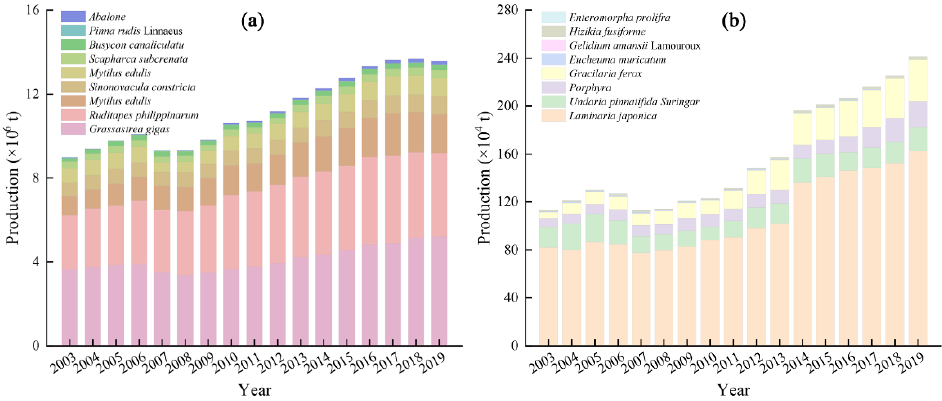
Figure 3. Output of ( a ) shellfish mariculture and ( b ) algae mariculture in China from 2003 to 2019. The average annual output of algae mariculture in China from 2003 to 2019 was 1.78 million tons, accounting for 12.65% of the total output of shellfish and algae mariculture. Laminaria japonica , Undaria pinnatifida Suringar , Porphyra , and Gracilaria ferox were the main algae species cultured in China (Figure 3b) and together accounted for 98.55% of the total output of algae, with Laminaria japonica being most popular and accounting for 68.44% of the algae output.